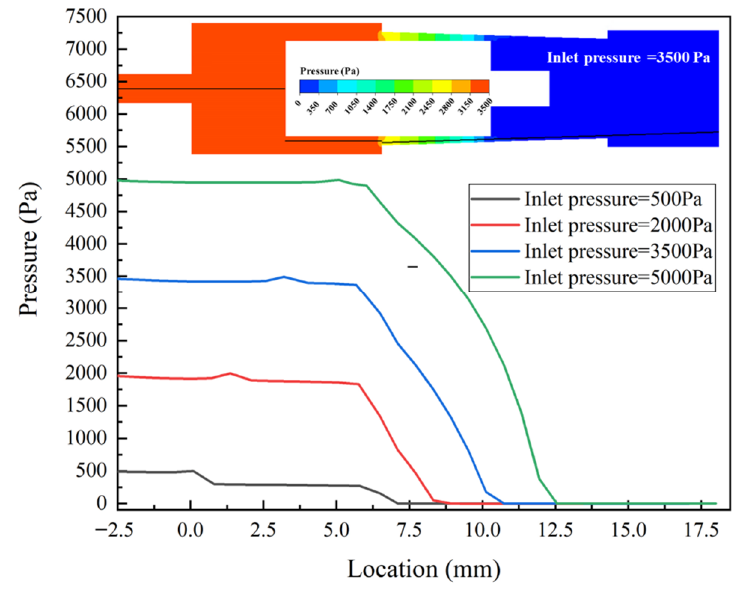
Figure 10. Pressure cures under varied inlet pressures.